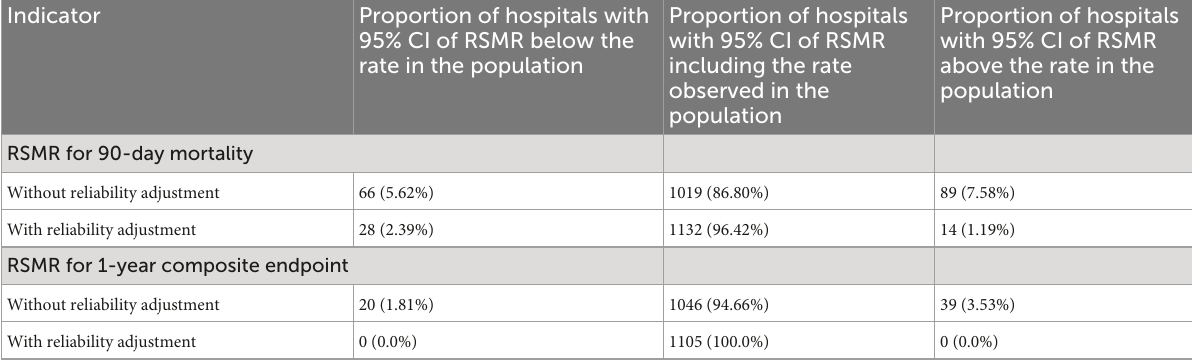
TABLE 3 Proportion of hospitals showing significant deviation of risk-adjusted outcomes from average.